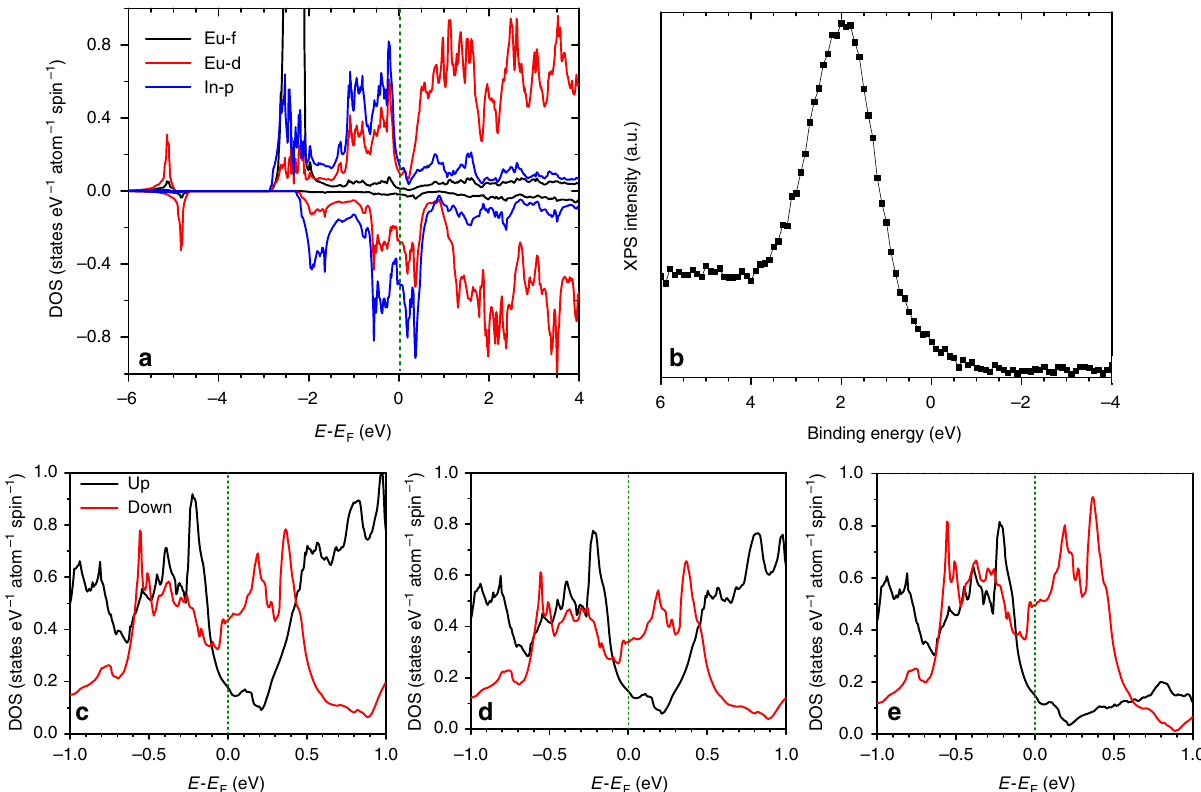
Fig. 5 Electronic structure of Eu 2 In. a Partial density of states (DOS) of Eu-I and In. b Valence band x-ray photon emission spectroscopy (XPS) measurements on Eu 2 In. Total DOS near E F ( c ) for Eu-I, d Eu-II, and e In atoms, in this energy range the DOS are dominated by Eu-5 d and In-5 p